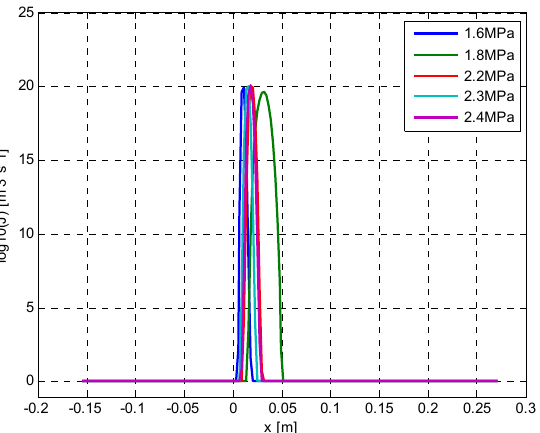
Figure 9. Nucleation rate curves along the axial cross-section of the supersonic separator.